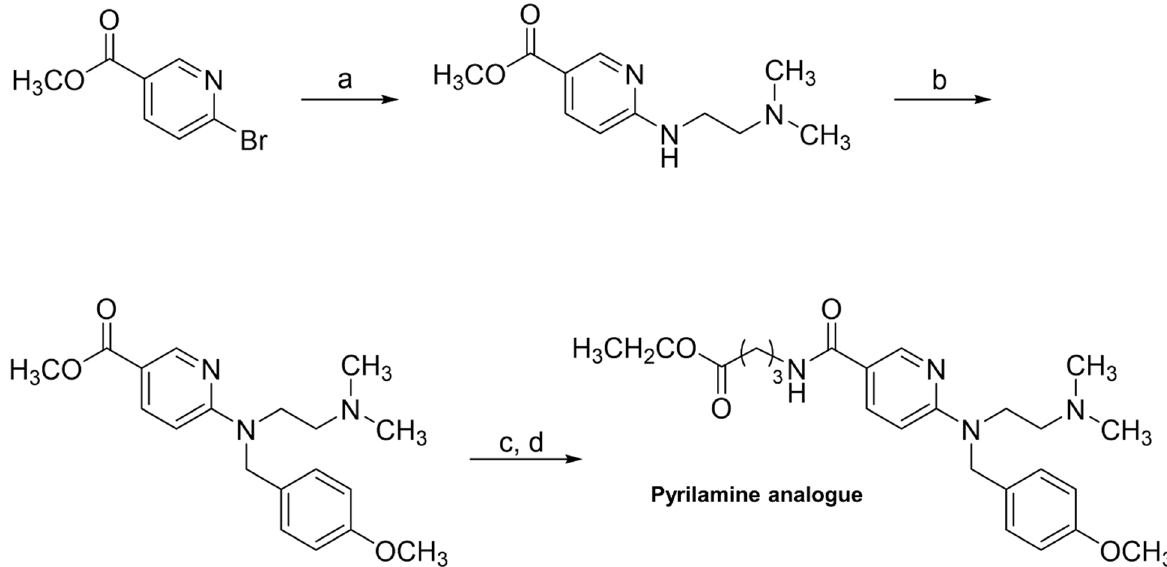
Figure 5. Synthesis of pyrilamine analogue as a new H + /OC antiporter substrate. ( a ) N,N -Dimethylethylendiamine, pyridine, 120 °C; ( b ) 4-methoxybenzyl chloride, NaH, THF rt; ( c ) aq. NaOH, CH 3 OH, 100 °C; ( d ) ethyl 4-aminobutyrate hydrochloride, ethyl-3-(3-dimethylaminopropyl) carbodiimide hydrochloride, 1-hydroxybenzotriazole, DIPEA, DMF, rt.